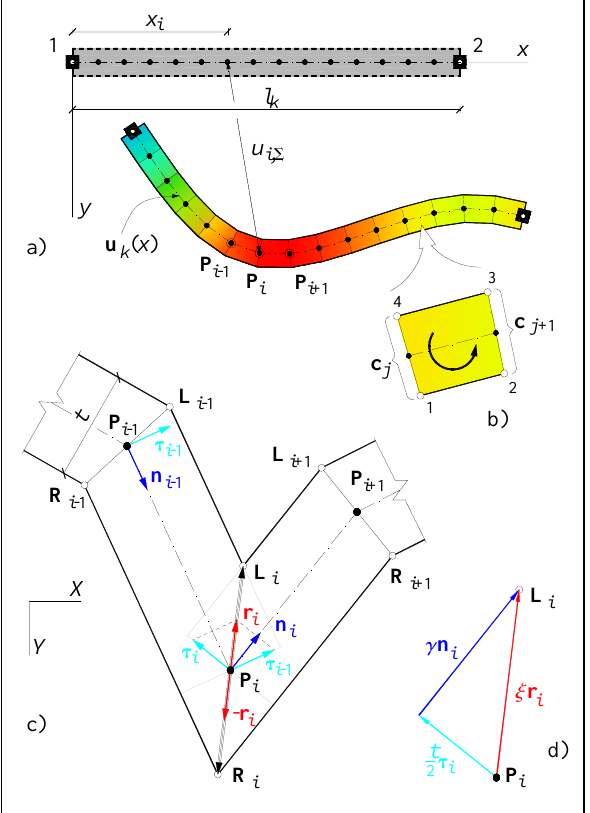
Fig. 19. Displacements and strains of the beam element: a) deformed element BEAM31; b) sequence of element surface colouring; c) creation of deformed element